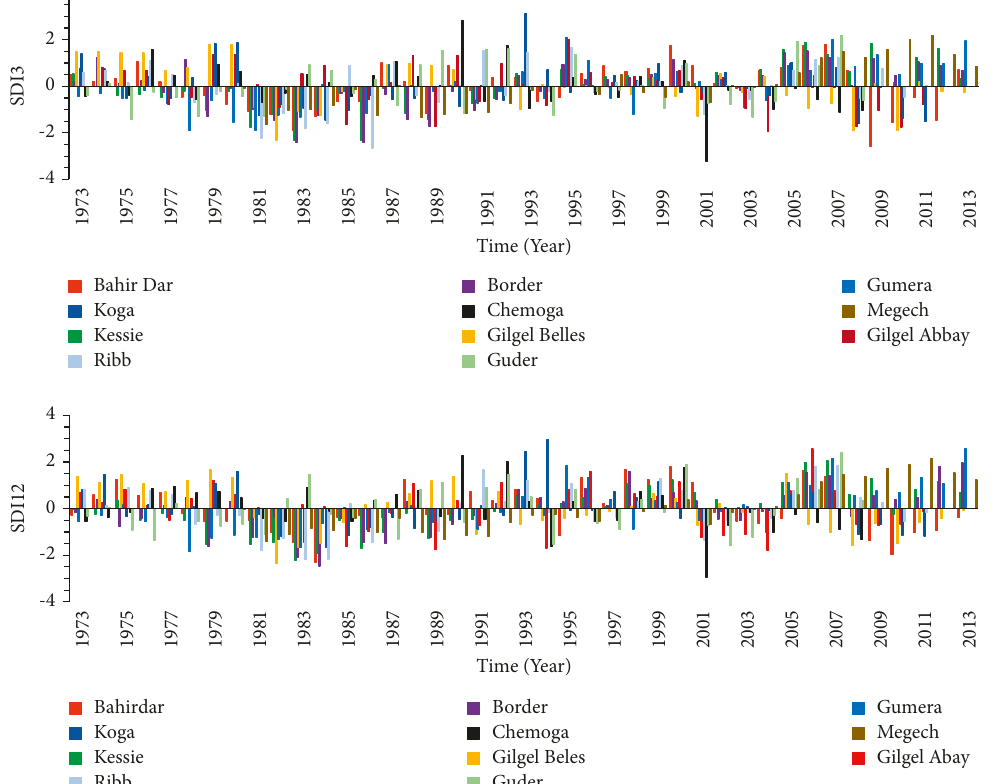
Figure 4: Temporal variation in seasonal (SDI3) and annual (SDI12) for Abbay river basin. Table 4: Hydrological drought years in different river basins in Ethiopia from 1973 to 2014. River